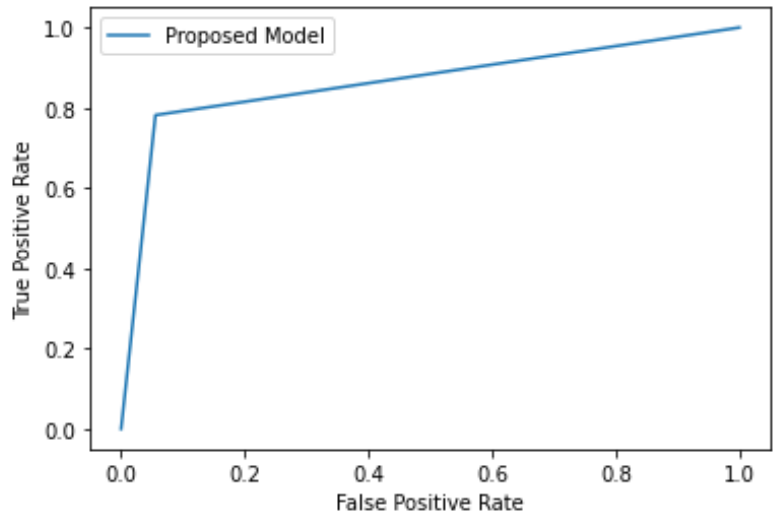
Figure 8. Confusion Matrix of Proposed Model.